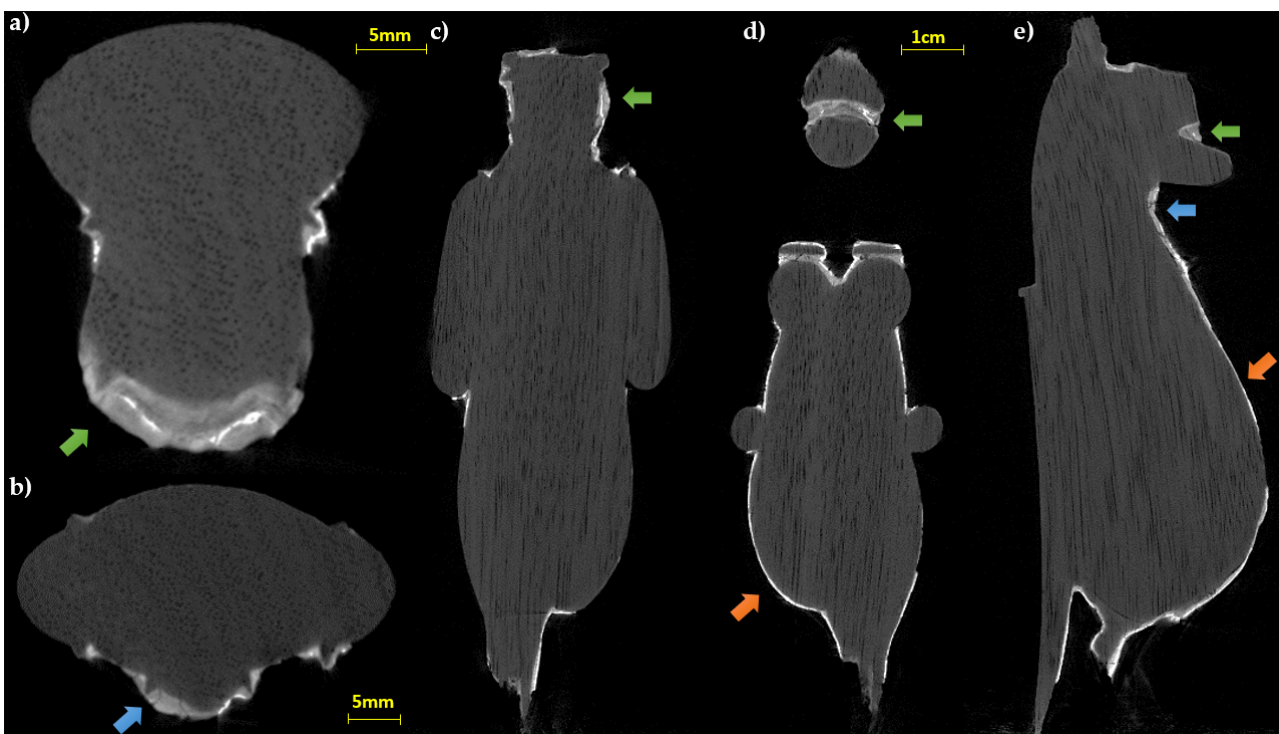
Figure 4. CT slices of the statuette: ( a , b ) horizontal sections; ( c – e ) longitudinal slices. In all the sections the wood structure (vessels and growing rings) is visible (green arrows: preparation layer in the face area; blue arrows: fractures inside the preparation layer; orange arrows: thin preparation material for the gold leaf adhesion).